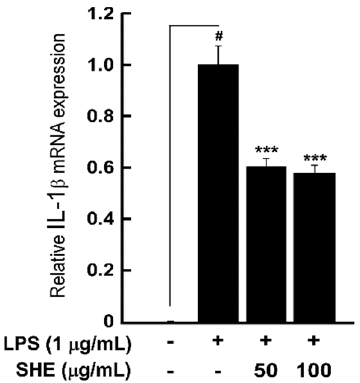
Figure 6. Effects of Soroseris hirsuta extract (SHE) on lipopolysaccharide (LPS)-induced interleukin-1 beta ( IL - 1 β ) mRNA expression in RAW 264.7 cells. The cells were first treated with SHE 1 h, and then LPS and SHE were co-treated and left for 24 h. Subsequent procedures were carried out as described in the Materials and Methods section. # p < 0.001 and *** p < 0.001.